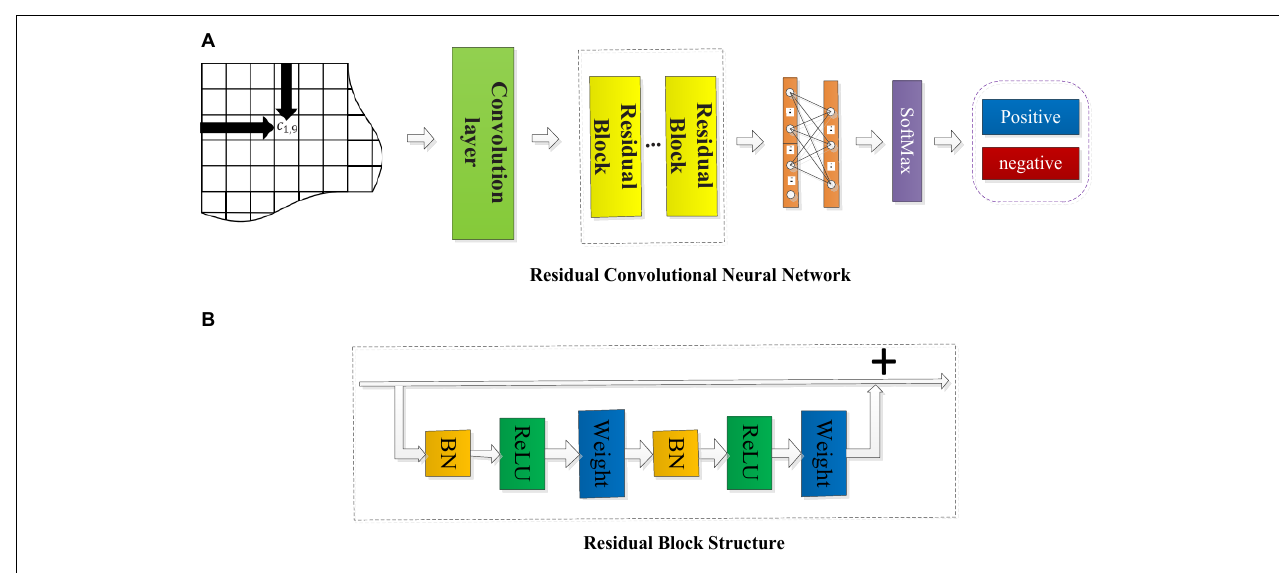
FIGURE 4 | The framework of the residual convolutional neural network and the structure diagram of the residual block. (A) The framework of RCNN model. (B) The structure of residual block.